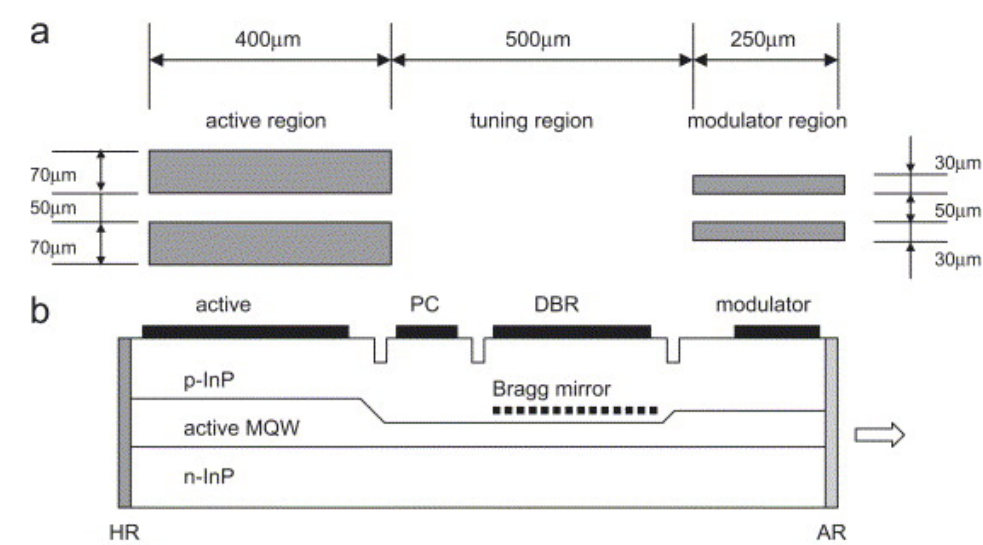
Figure 22. ( a ) Geometry of the SiN x mask and ( b ) schematic diagram of an EAM integrated with a tunable DBR laser. Reprinted with permission from ref. [83] © Elsevier. Copyright 2007 Journal of Crystal Growth.